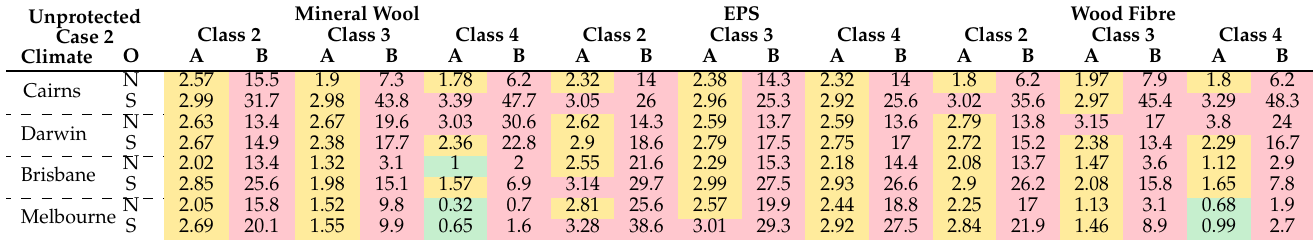
Table 9. Unprotected CLT results for external insulation. O (orientation). Performance criteria: A (mould growth index), B (corrosion rate). Classification of WRB: Class 2, 3, and 4 (vapour permeance). Green (pass), red (fail), or yellow (further